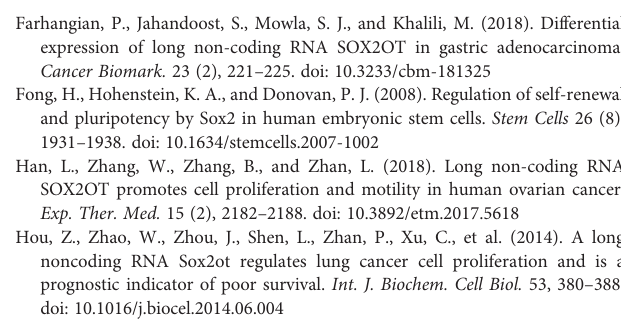
SUPPLEMENTARY FIGURE 1 | Relationship of SOX2-OT expression and DFS in various cancers. SUPPLEMENTARY FIGURE 2 | Meta-analysis of TCGA datasets estimating the association of SOX2-OT with the patients ’ overall survival (OS). SUPPLEMENTARY FIGURE 3 | Kaplan-Meier survival curves for overall survival of 16 cancers in TCGA, strati fi ed by SOX2-OT expression levels. (A) ACC, (B) BLCA, (C) BRCA, (D) CESC, (E) CHOL, (F) COAD, (G) DLBC, (H) ESCA, (I) HNSC, (J) KICH, (K) KIRC, (L) KIRP, (M) LAML, (N) LGG, (O) LIHC, (P) LUAD. SUPPLEMENTARY FIGURE 4 | Kaplan-Meier survival curves for overall survival of the other 16 cancers in TCGA, strati fi ed by SOX2-OT expression levels. (A) LUSC, (B) MESO, (C) OV, (D) PAAD, (E) PCPG, (F) PRAD, (G) READ, (H) SARC, (I) SKCM, (J) STAD, (K) TGCT, (L) THCA, (M) THYM, (N) UCEC, (O) UCS, (P) UVM. SUPPLEMENTARY FIGURE 5 | Totally 500 target genes of SOX2-OT were identi fi ed with Multi Experiment Matrix (MEM). SUPPLEMENTARY TABLE 1 | Databases searching terms. (A) Search criterion of Medline (via PubMed, from inception to Jan 1st, 2019) (n=47), (B) Search criterion of Embase (from 1966 to Jan 20, 2019) (n=49), (C) Search criterion of Cochrane Library (Jan 1st, 2019) (n=1). SUPPLEMENTARY TABLE 2 | Results of quality assessment using the Newcastle – Ottawa Scale for the included studies. SUPPLEMENTARY TABLE 3 | Meta-regression analysis of heterogeneity for clinicopathological parameters in cancers. SUPPLEMENTARY TABLE 4 | Subgroup analysis for SOX2-OT overexpression and clinicopathological parameters in